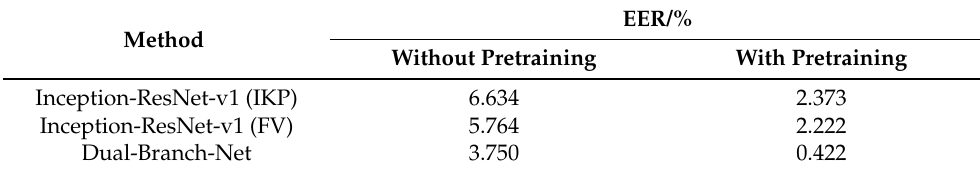
Figure 7. ROC curves of different recognition schemes with and without pretraining. Table 4. Results of experiments with and without